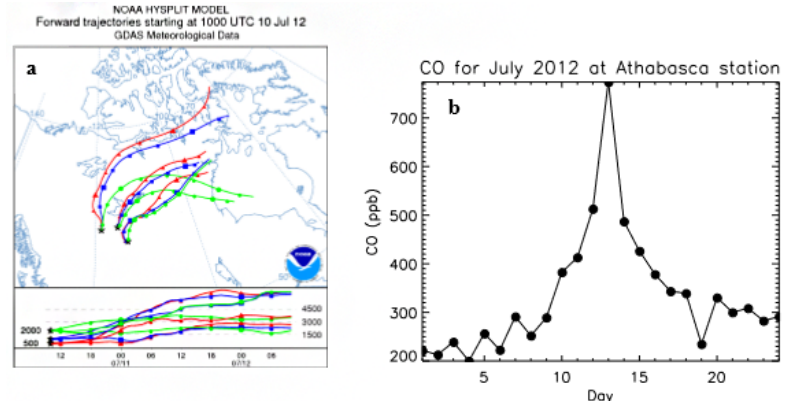
Figure 14. (a) 48h HYSPLIT forward trajectory starting on 10 July 2012 and (b) daily CO at the Athabasca Valley station for July